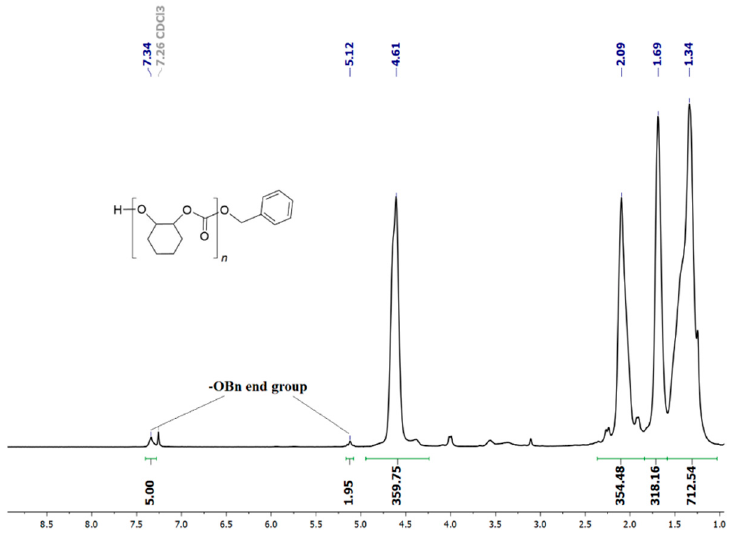
Figure 2. 1 H NMR spectrum (400 MHz, CDCl 3 , 25 °C) of PCHC (from entry 2 of Table 2).